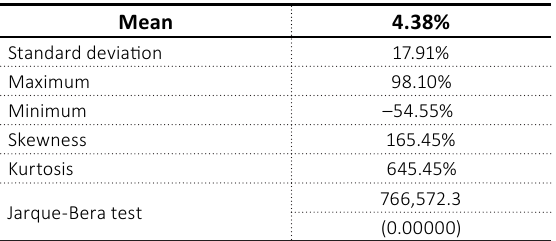
Table 1. Descriptive statistics on Bitcoin